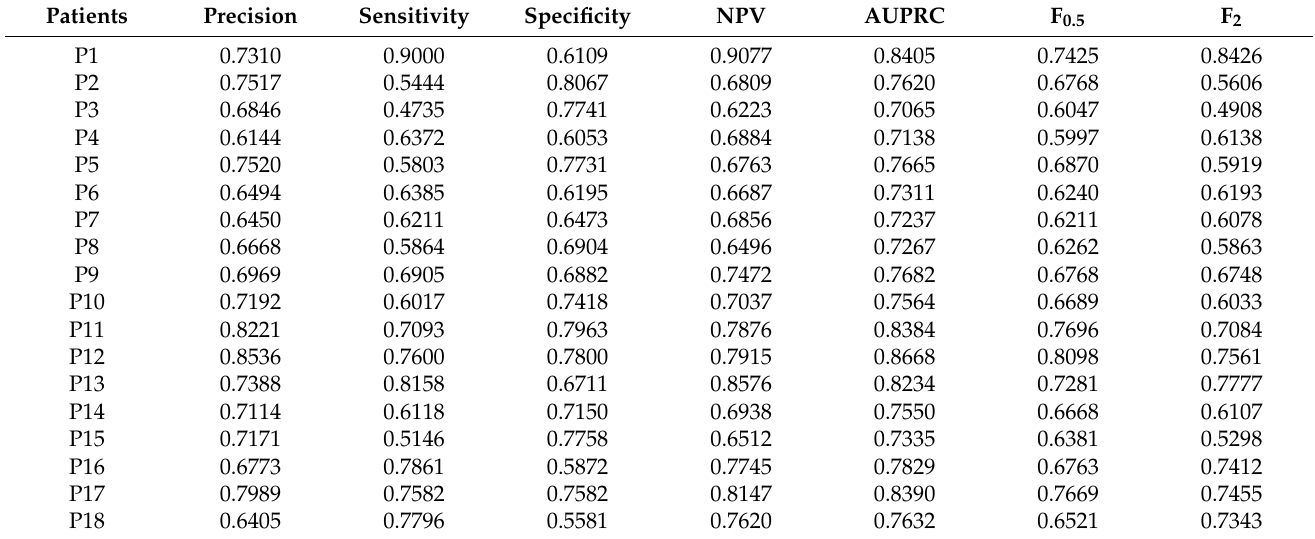
Table 6. Additional evaluation metrics ( Bayesian ) for all